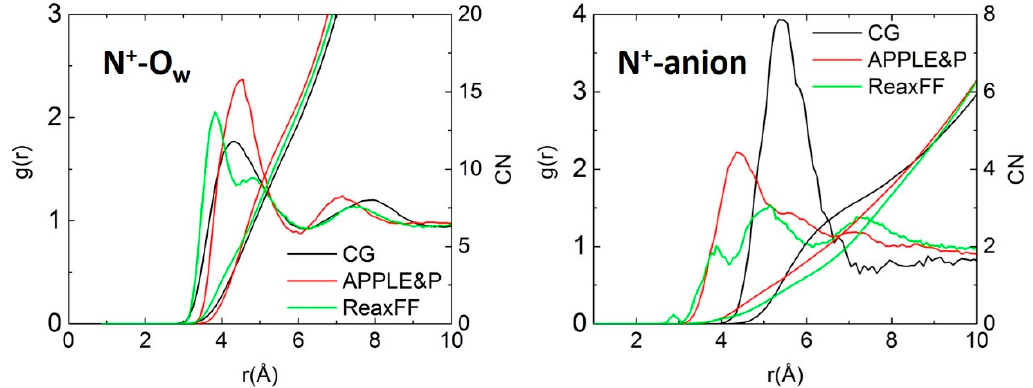
Figure 4. Comparison of radial distribution functions (RDF) and coordination numbers (CN) obtained from different models: ( left ) N + -O w and ( right ) N + -anion.